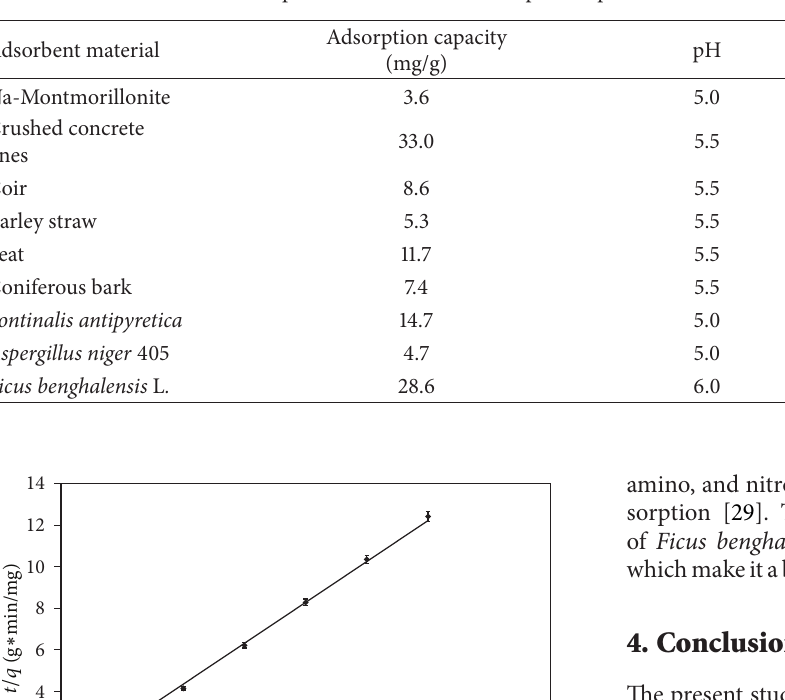
Table 5: Comparison of maximum adsorption capacities for lead adsorption to different adsorbents.